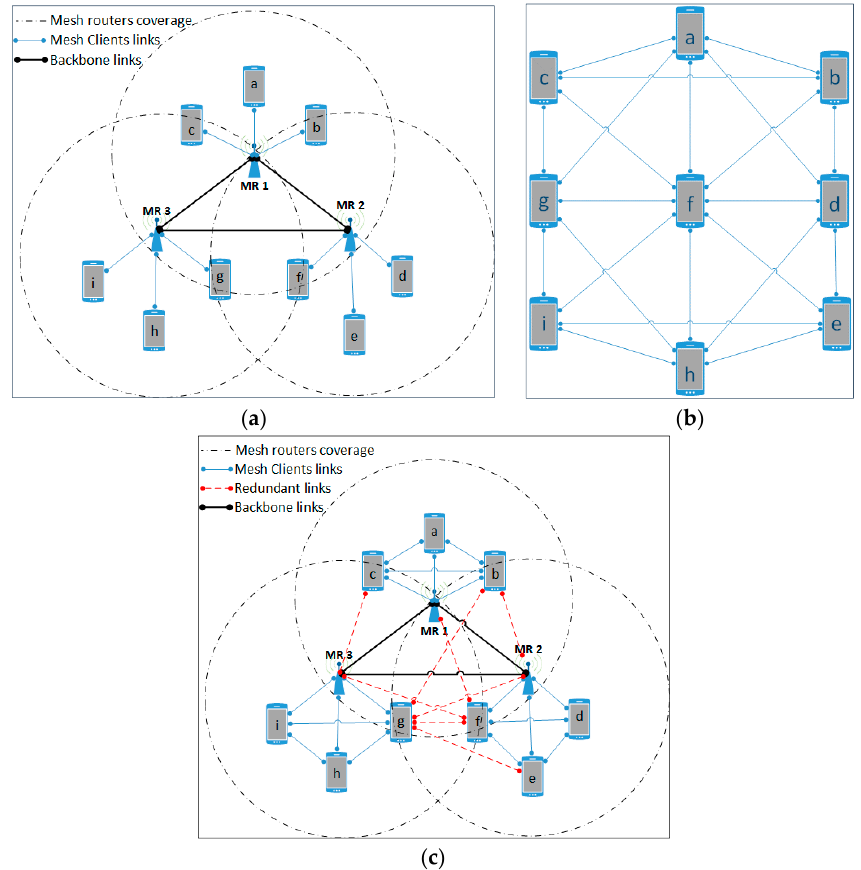
Figure 1. Three types of wireless mesh networks: ( a ) Backbone mesh with each router supporting a separate service set and clients connected in infrastructure mode with the routers; ( b ) ad hoc or clients mesh (MANETs), where the network is formed without dependency to any wireless router or access point; ( c ) backbone and clients mesh in which nodes can roam and connect to any available mesh node or router in any cell.